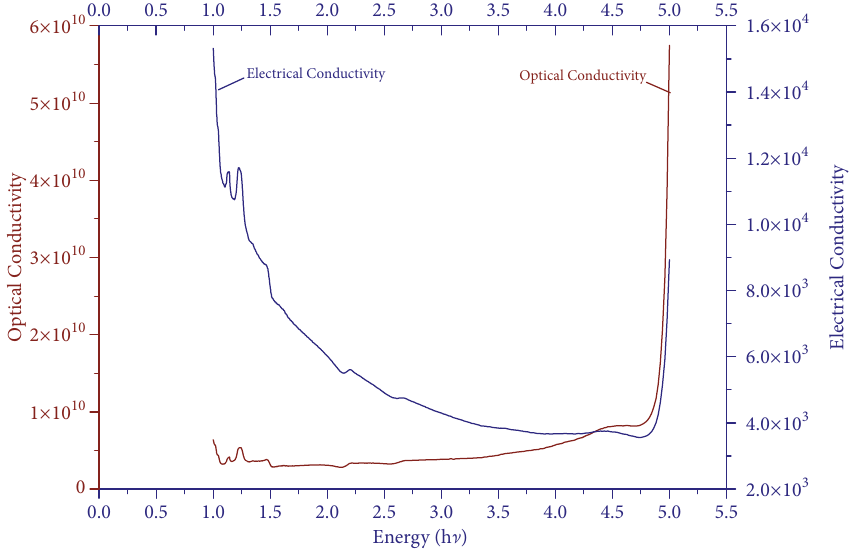
Figure 9: Optical conductivity of IMLT